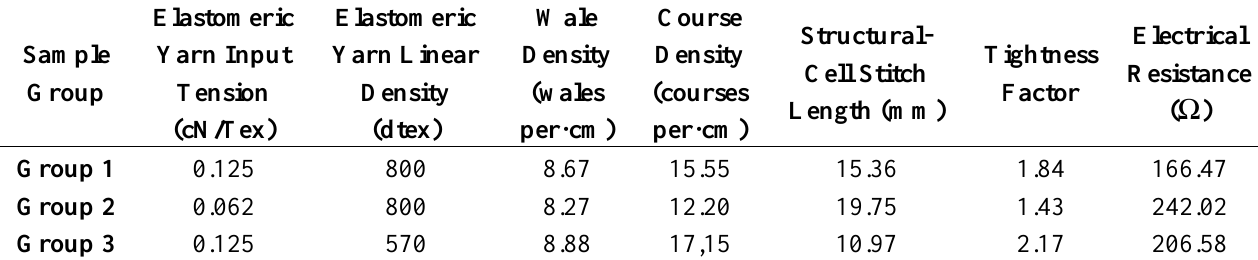
Table 2. Comparison of average electrical resistance and average base fabric